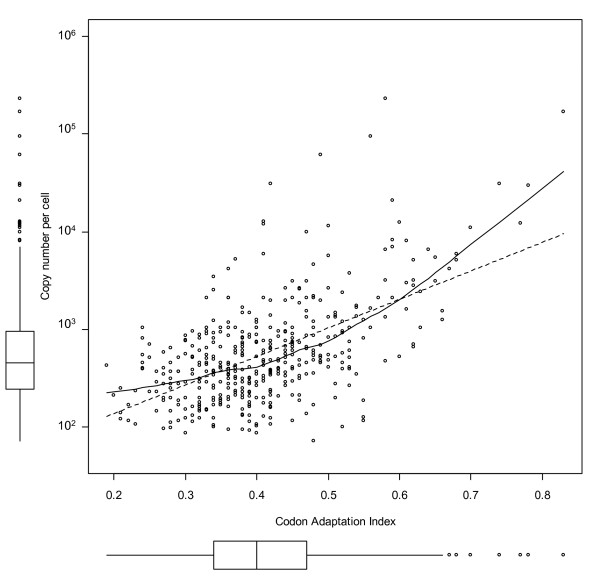
Abundance versus codon adaptation index (CAI). Each point on the plot corresponds to a protein characterized by two values: abundance and CAI. The Spearman rank correlation coefficient rs between log-copy number and CAI is 0.5 and the Pearson correlation coefficient is 0.57 indicating a good non-random (p-values both < 10-16) correlation with some variance. The dotted line is a linear regression between log(copy number) and CAI, the solid line a loess local fitting curve.